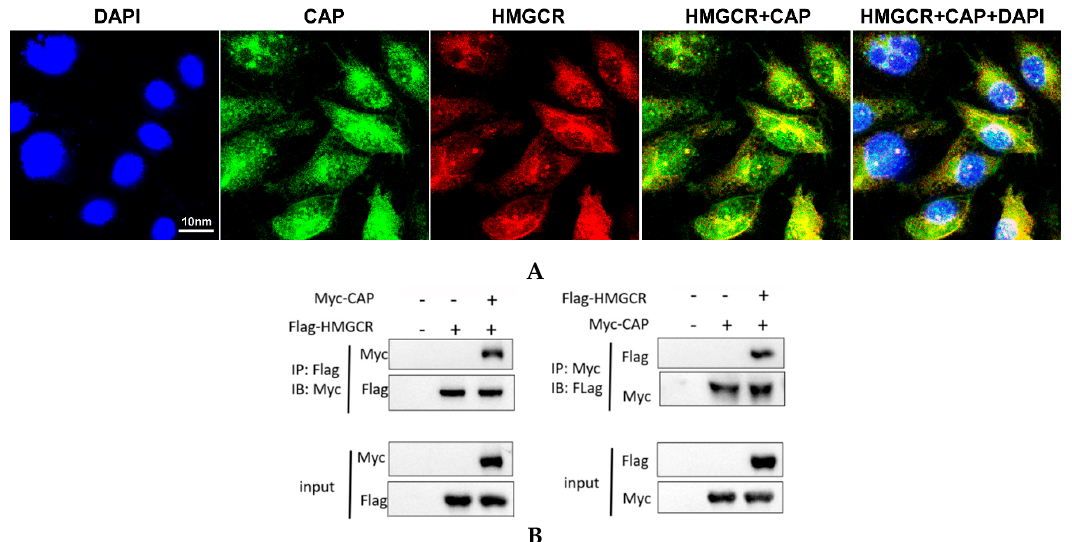
Figure 6. Interaction between HMGCR and PCV2 Cap protein. ( A ) Colocalization of HMGCR and PCV2 Cap protein. HMGCR (Cy3; red), PCV2 Cap protein (FITC; green), DAPI (blue) and overlap (yellow), scale bar: 10nm. ( B ) Co-IP of HMGCR and PCV2 Cap protein. Flag (HMGCR), Myc (Cap).